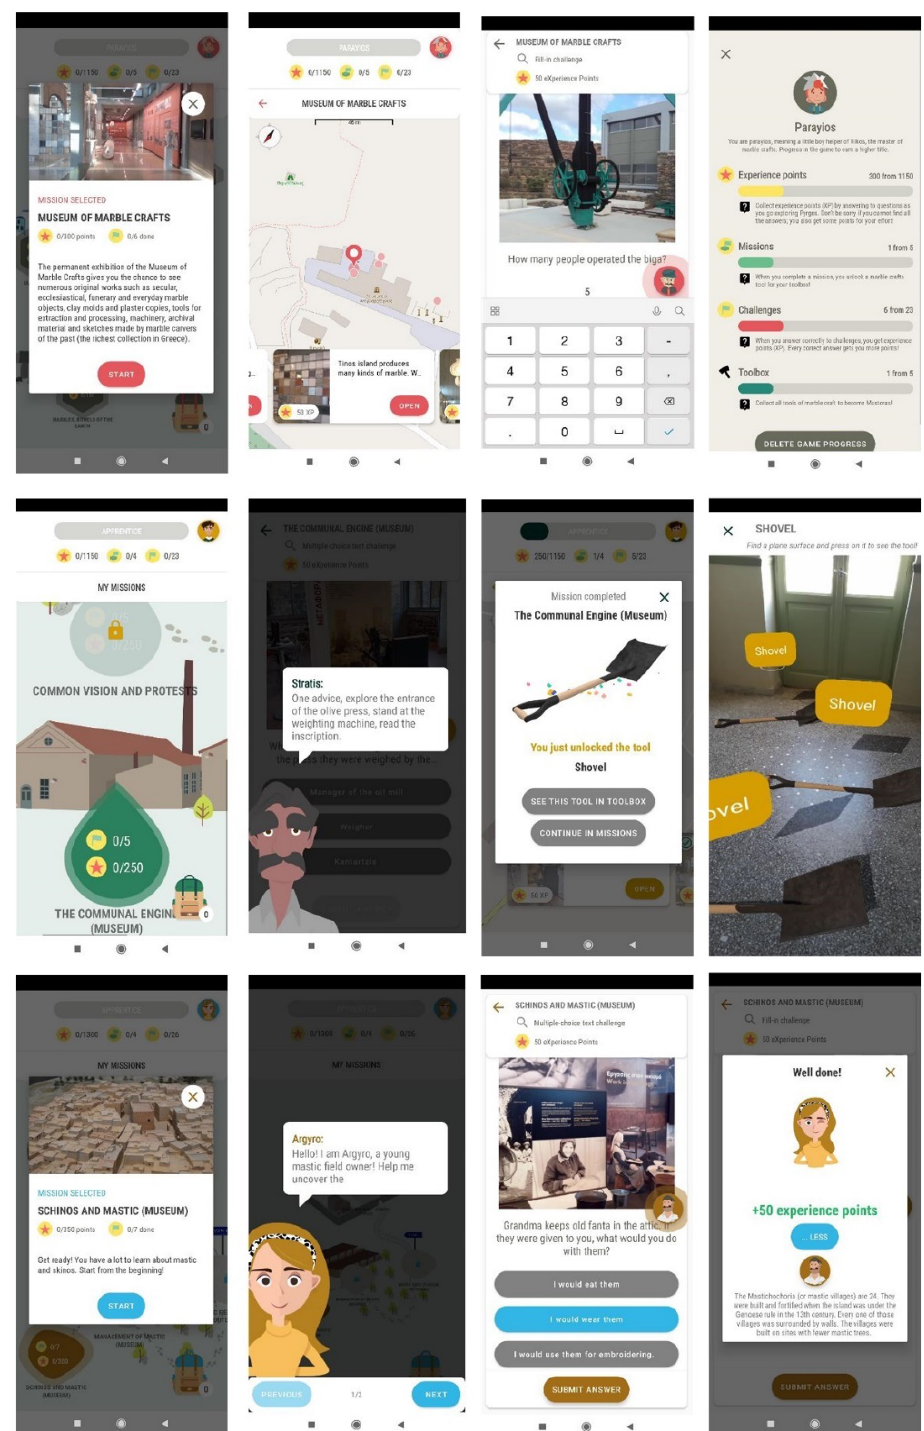
Figure 8. Screen shots of the final implementation of mobile games. Upper row: game ‘Explore the Marble Town’ (Mouseion Topos #Tinos). From left to right: a selected mission from mission map; the challenges map and list; a challenge question (fill-in type); the user profile screen. Middle row: ‘People’s Machine’ game. From left to right: missions map; the master character helping on a challenge; a tool earned after mission completion; AR view of the tool. Lower row: ‘Mastic and Mastichochora’ game. From left to right: mission selected from the mission map; the young character onboarding; a challenge question (help is available in animation); challenge completion card with more